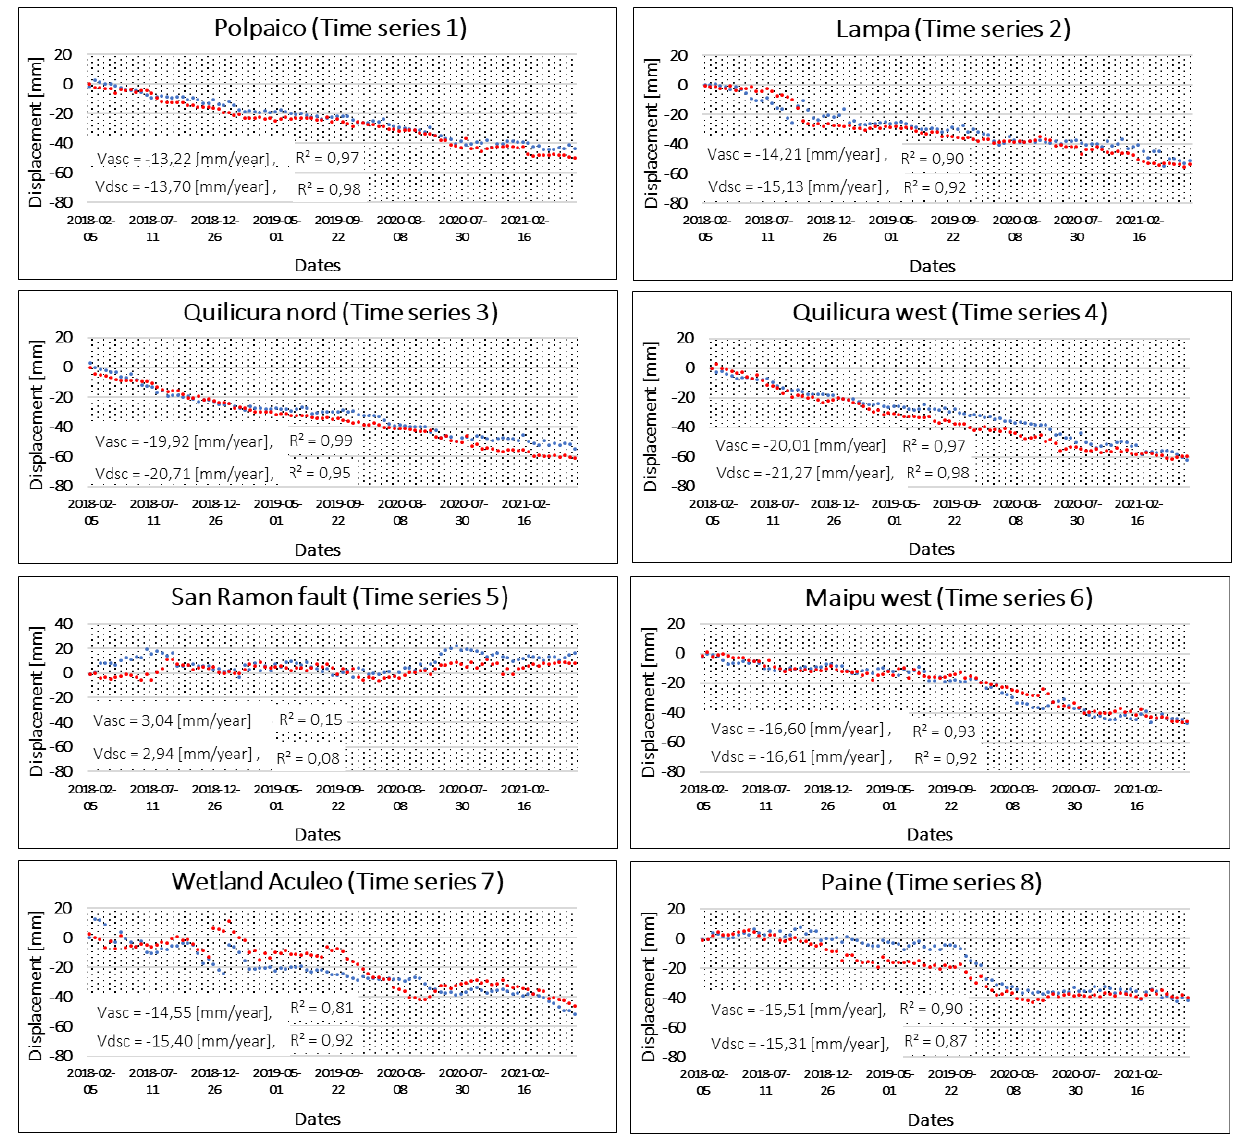
Figure 6. Time series 1 – 8 in red ascending orbit and blue descending orbit, located at Polpaico, Lampa, Quilicura nord, Quilicura west, San Ramon fault, Maipu west, Wetland Aculeo, and Paine.